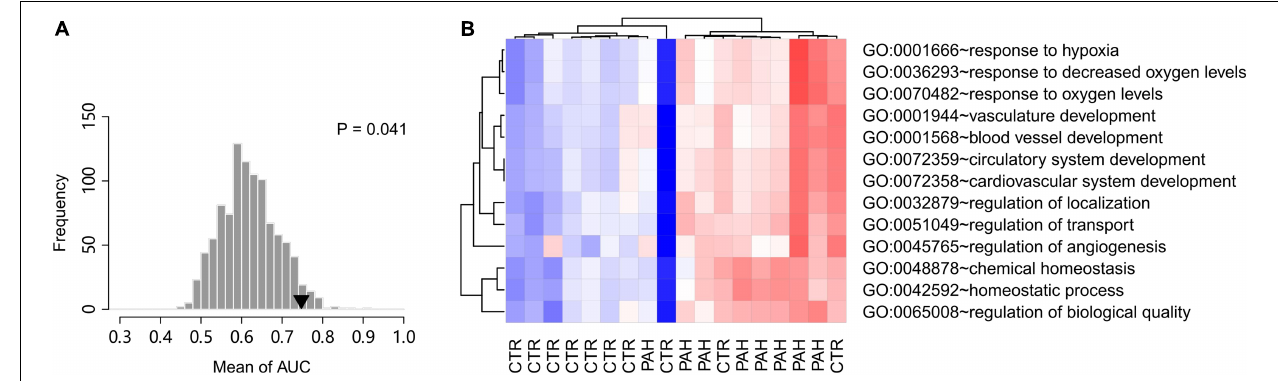
FIGURE 3 | Gene set score heatmap of the HIF2 α -mediated GO biological process terms in human PBMCs. (A) Superior predictive power of the HIF2 α -mediated GO terms compared with randomized pattern. The histogram shows the distribution of the mean of AUC (both the validation cohorts A,B ) for the 1,000 resampled GO term sets (The same size as the HIF2 α -mediated GO terms, i.e., 14 GO terms). The mean of AUC of the 14 HIF2 α -mediated GO terms is marked with black triangle. Right-tailed P -value was generated from sampling distribution. (B) In total, 13 GO terms up-regulated in PBMCs from PAH patients were listed. Red and blue represent relative up-regulation and down-regulation of gene expression,